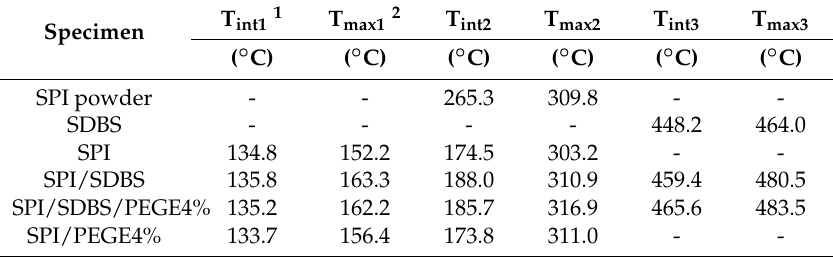
Table 2. TG parameters for the thermal degradation of SPI powder, SDBS, and SPI-based films. Specimen